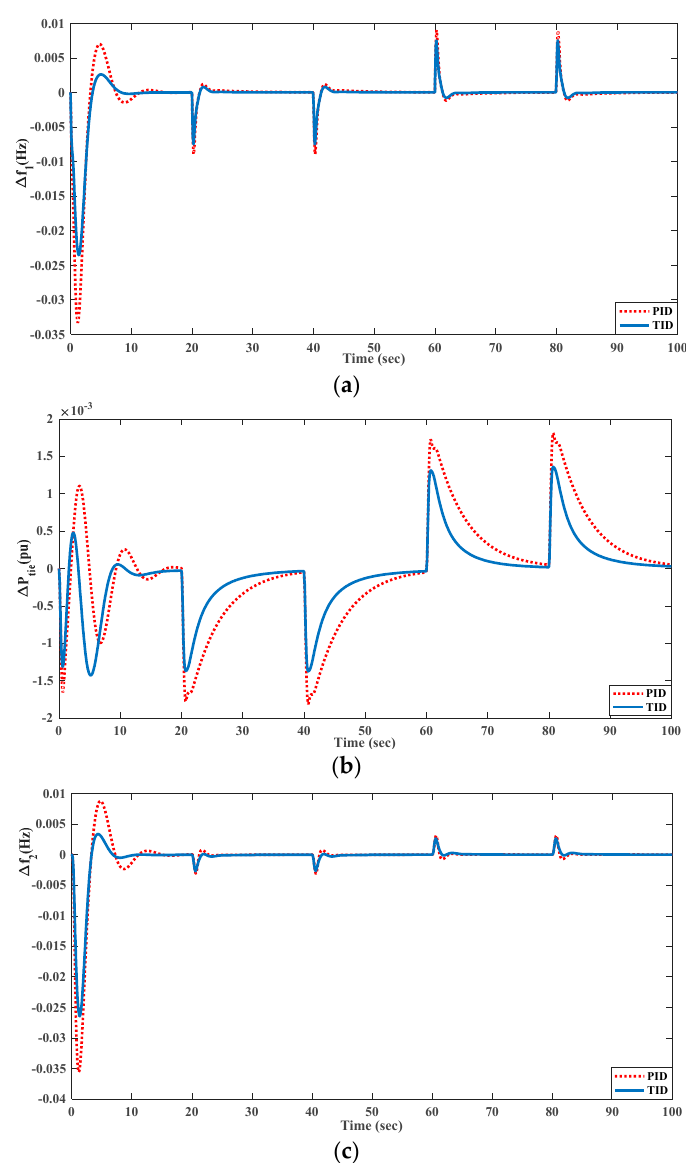
Figure 14. System dynamics with random load perturbation (RLP) for the PID and TID controllers. ( a ) ∆ f 1 ; ( b ) ∆ P tie ; ( c ) ∆ f 2